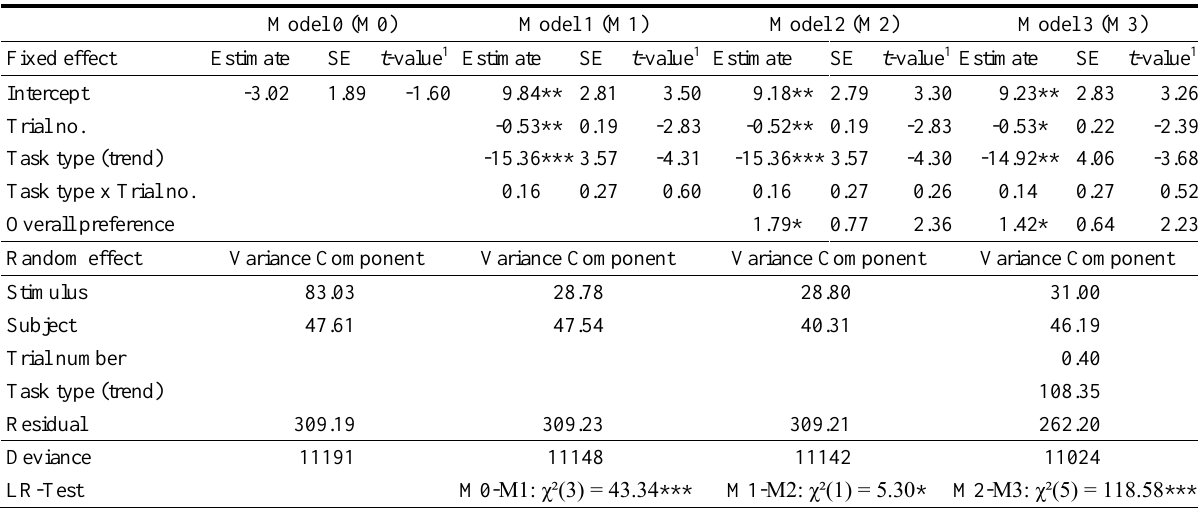
Table 2. Comparison of fixed effects and random effects in the linear mixed-effects